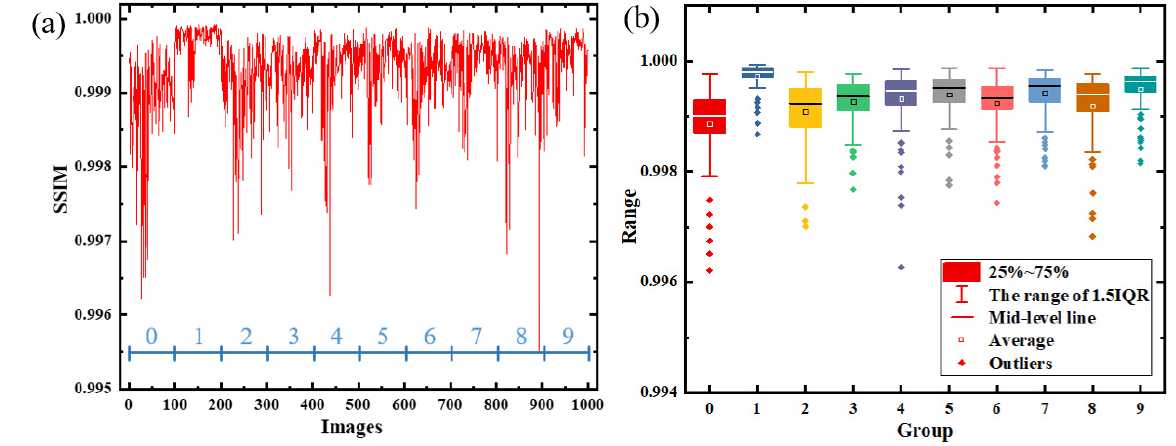
Figure 10. Structural similarity of ECGH reconstructed images: ( a ) curve plot; ( b ) box plot.